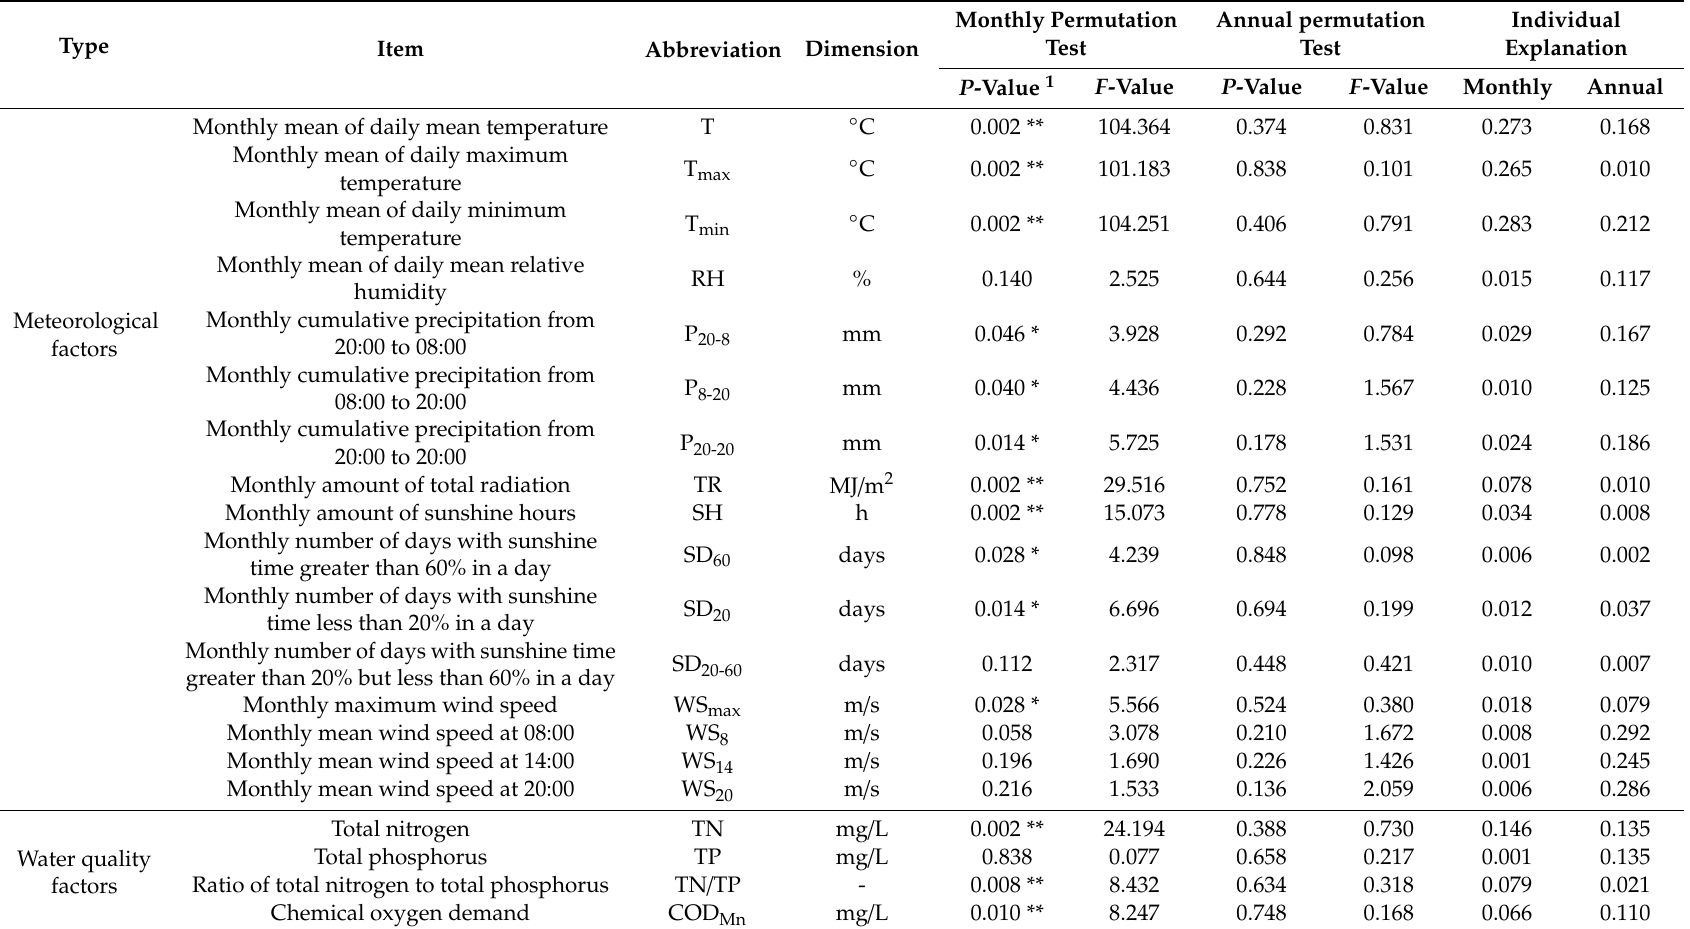
Table 4. Redundancy analysis (RDA) input variables and related